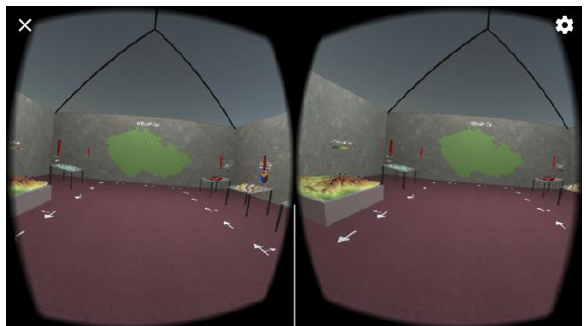
Figure 5. First-person view on Carthoreality. Screen is divided for display in a low cost